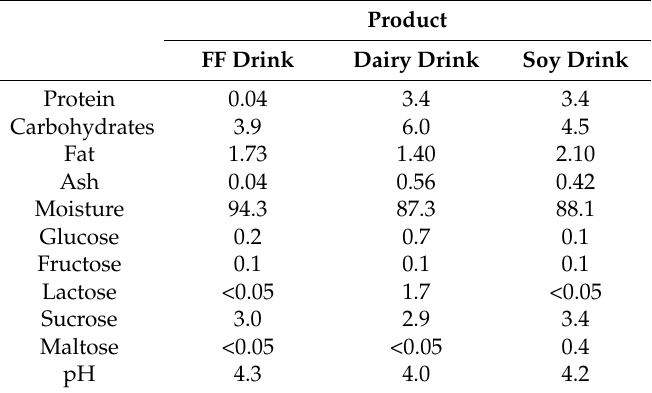
Table 1. Nutrient composition of the three test drinks. Product FF Drink Dairy